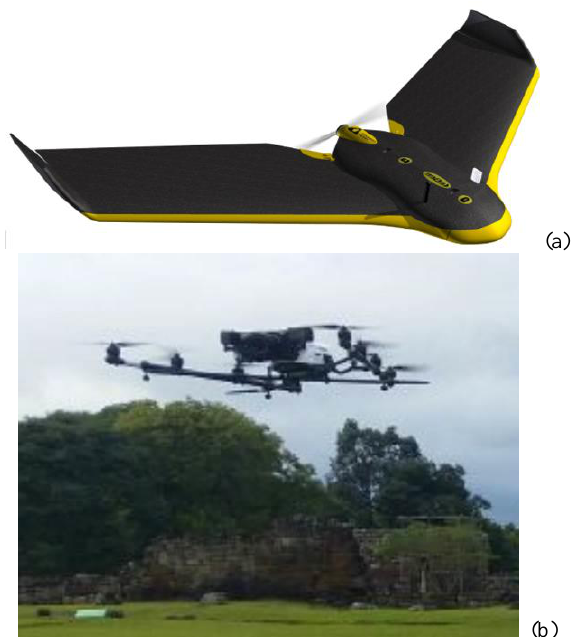
Figure 8 – UAV systems: (a) Sensefly eBee; (b) Asctec